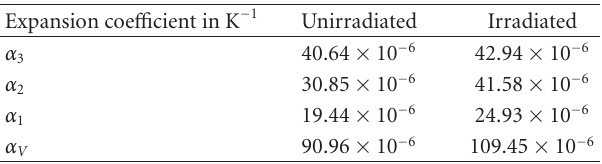
Table 9: Linear and volume expansion coe ffi cients of unirradi- ated and electron irradiated L-threonine single crystals at 12 × 10 14 e/cm 2 . Expansion coe ffi cient in K − 1 Unirradiated Irradiated α 3 40.64 × 10 − 6 42.94 × 10 − 6 α 2 30.85 × 10 − 6 41.58 × 10 − 6 α 1 19.44 × 10 − 6 24.93 × 10 − 6 α V 90.96 × 10 − 6 109.45 × 10 − 6